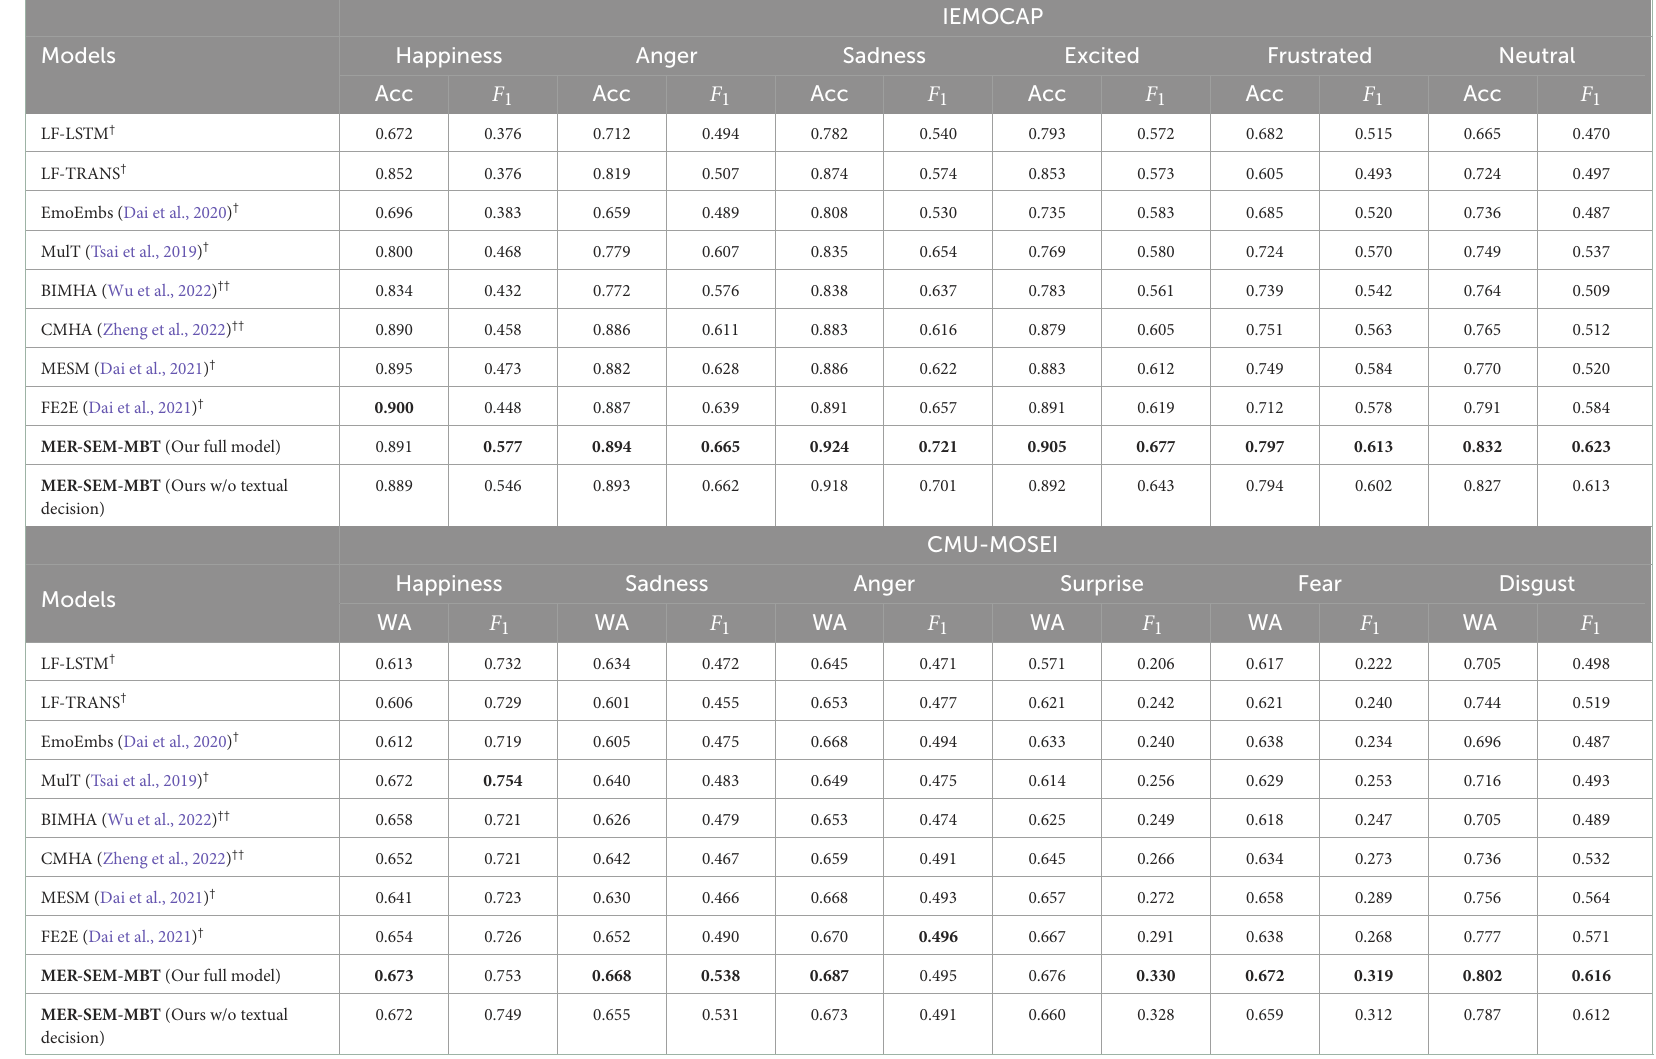
TABLE 2 Binary classification results of each emotion category on IEMOCAP and CMU-MOSEI datasets.